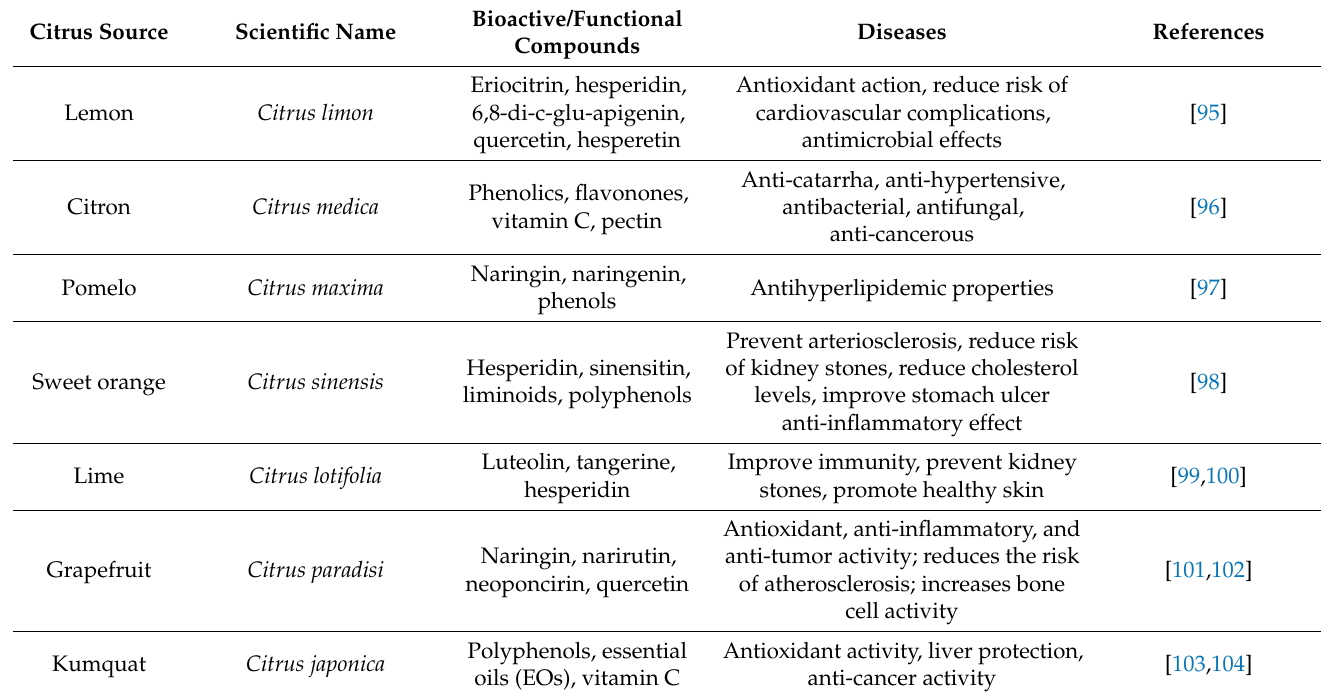
Figure 5. Bioactive compounds in citrus waste and their health benefits. Table 2. Health benefits of bioactive compounds in citrus.